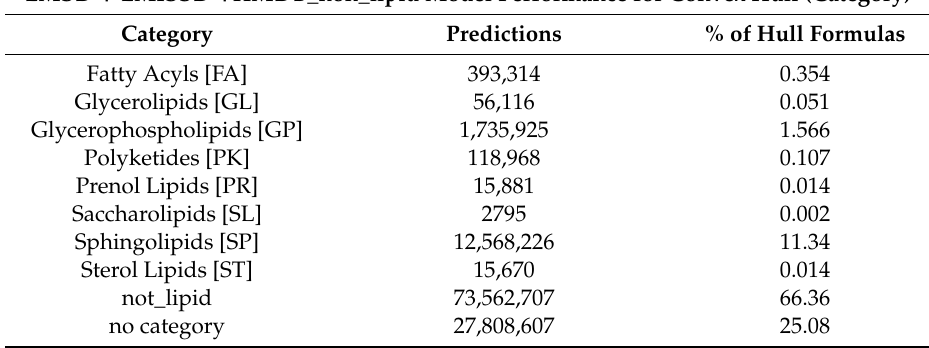
Table 4. LMSD + LMISSD + HMDB_non_lipid model performance for convex hull (category).